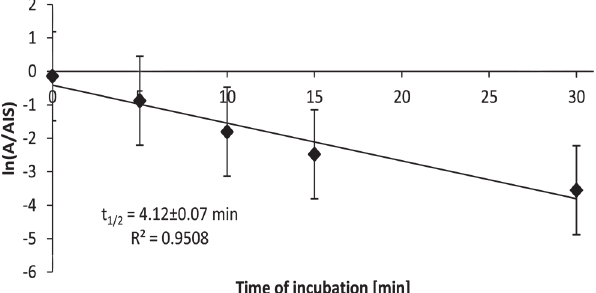
Fig 3. Plot showing relationship used to calculate t 0.5 . The average value of the natural logarithm of the compound peak area to internal standard peak area ratio are